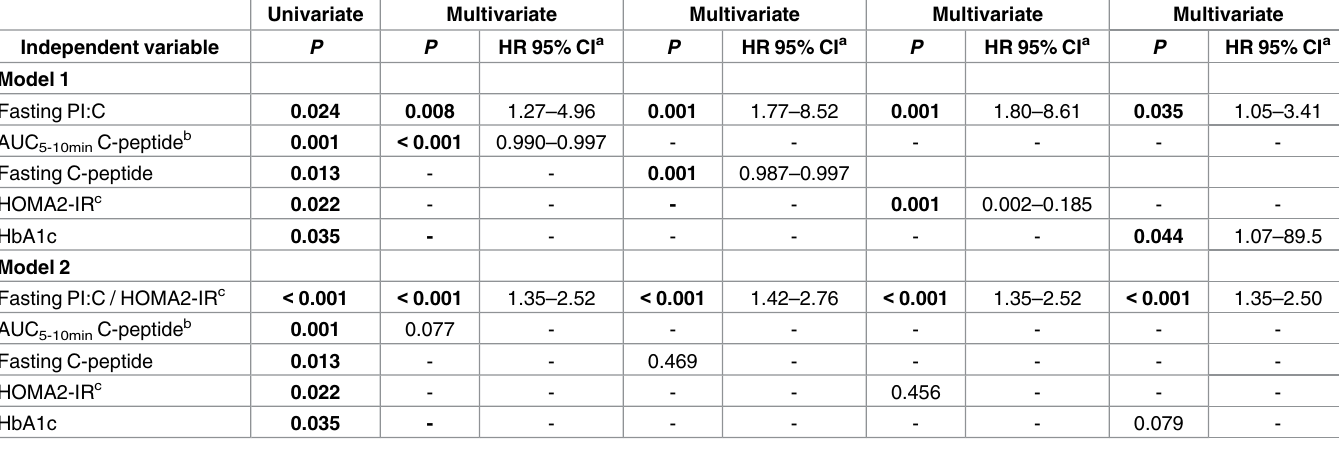
Table 3. Cox regression analysis for 2-year progression (10 events) to type 1 diabetes in 49 first-degree relativesat high autoantibody-inferred risk (HR) (IA-2A + or ZnT8A + plus (cid:21) 1 other autoantibody) [9]. All variables from Table 2 were tested univariately. Only those with univariate P < 0.1 are shown here and were entered in two-by-two multivariate